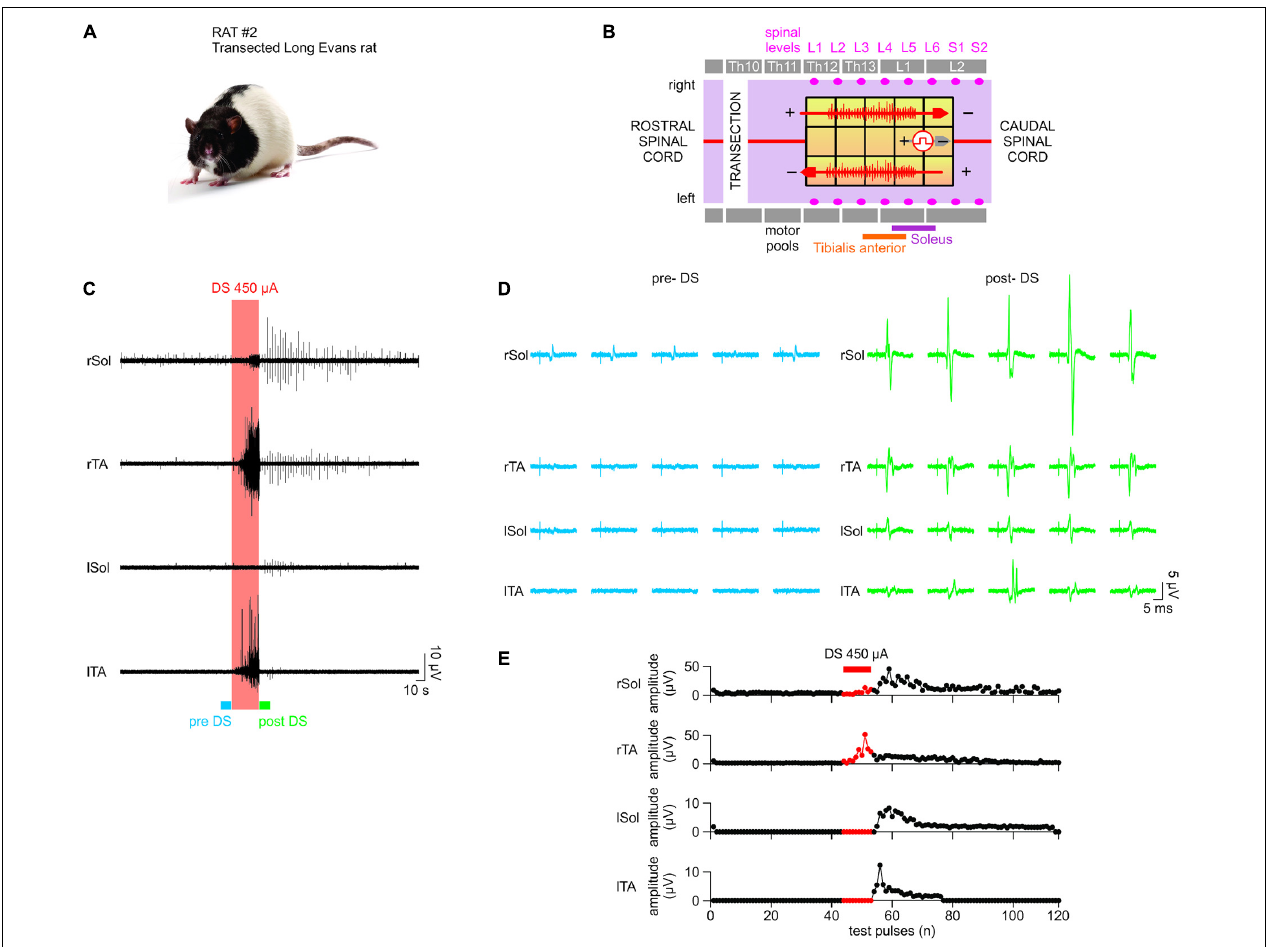
FIGURE 9 | In vivo test results II. The stimulator prototype repeats the in vivo test in a rat subject with a completely transected spinal cord. (A) Animal type used in this experiment. (B) Transection is made at the Th10 level (white vertical bar). While the DS protocol is delivered to the same electrode locations as in in vivo test I, the test pulse is delivered to different electrodes, which were experimentally chosen to ensure the presence of EMG responses with the spinal cord transection prior to application of DS. (C–E) Notably, although consistent responses were not present in the left motor outputs pre-DS, due to the transection, consistent responses appeared on all four EMG electrodes at significantly increased amplitude levels post-DS. This demonstrates the efficacy of the stimulator prototype, which effectively delivers the DS protocol to exploit any spared spinal cord connectivity and restore the motor outputs following a spinal cord